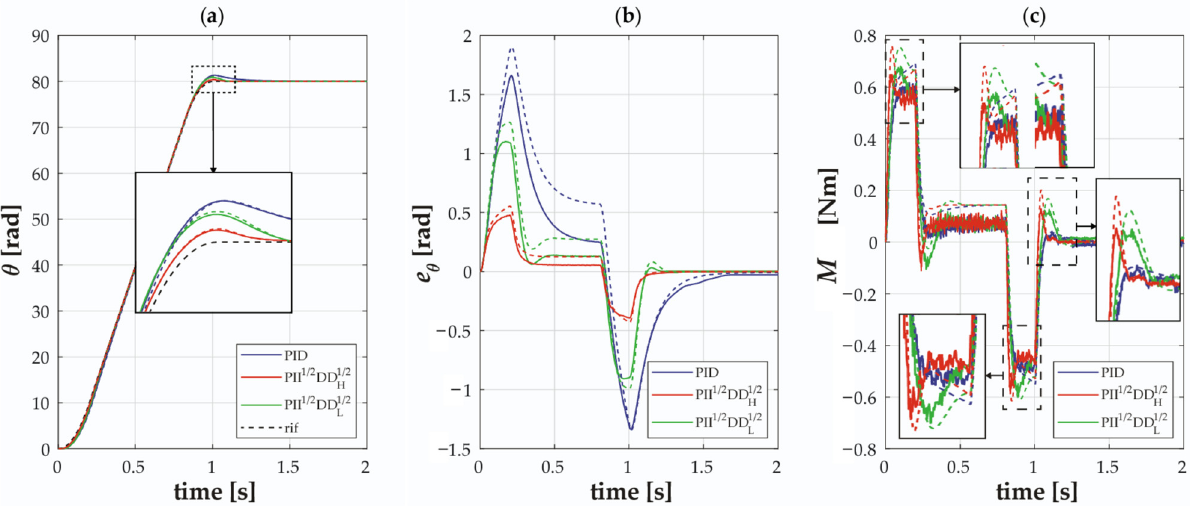
Figure 13. Trapezoidal speed law response, comparison of ET (continuous line) and DTS (dashed line): angle θ ( a ), error e θ ( b ) and motor torque M ( c ); PID: blue; PII 1/2 DD 1/2 H : red; PII 1/2 DD 1/2 L : green; set-point: black. Table 2. Comparison of simulation results with PD, PII 1/2 DD 1/2 H , and PII 1/2 DD 1/2 L ; for PII 1/2 DD 1/2 H , and PII 1/2 DD 1/2 L the variations with respect to PID are reported.